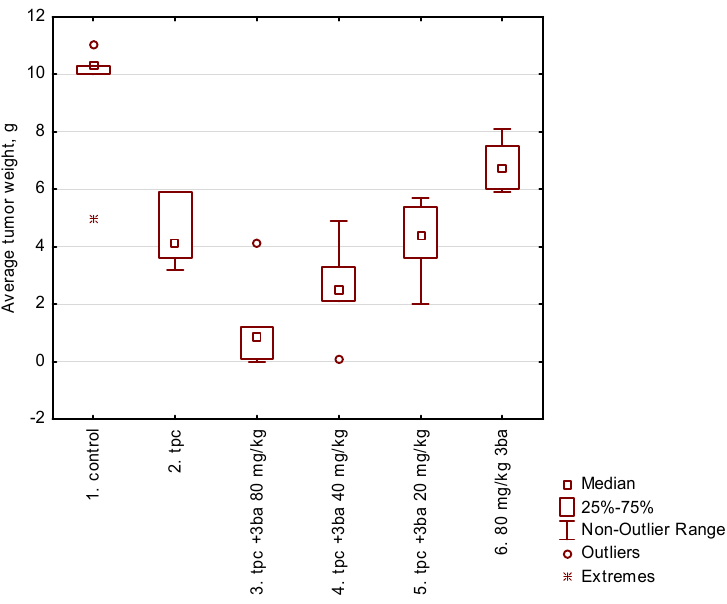
Figure 4. Box plot of the 3ba influence on the antitumor effect of tpc against Krebs-2 carcinoma with intraperitoneal administration. P 1–2 = 0.002; P 1–3 = 0.00013; P 2–3 = 0.04. The differences between group 2 and groups 4–6 are not significant.